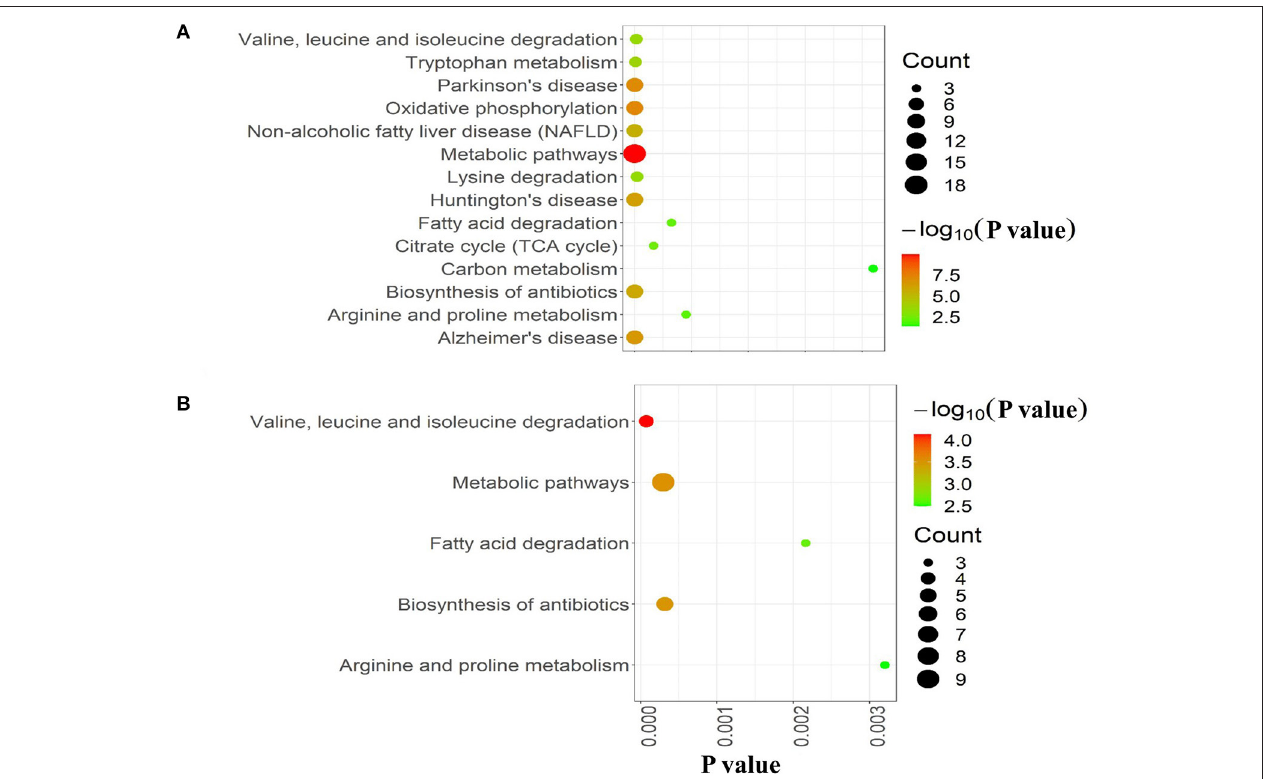
FIGURE 3 | Reactome pathway analysis of DAPs. (A) Upregulated and (B) downregulated proteins in the mitochondria of yak brain tissue compared with that of cattle. The x-axis shows each of the enriched pathways. The y-axis represents the number of differentially abundant proteins (DAPs) in each primary category.